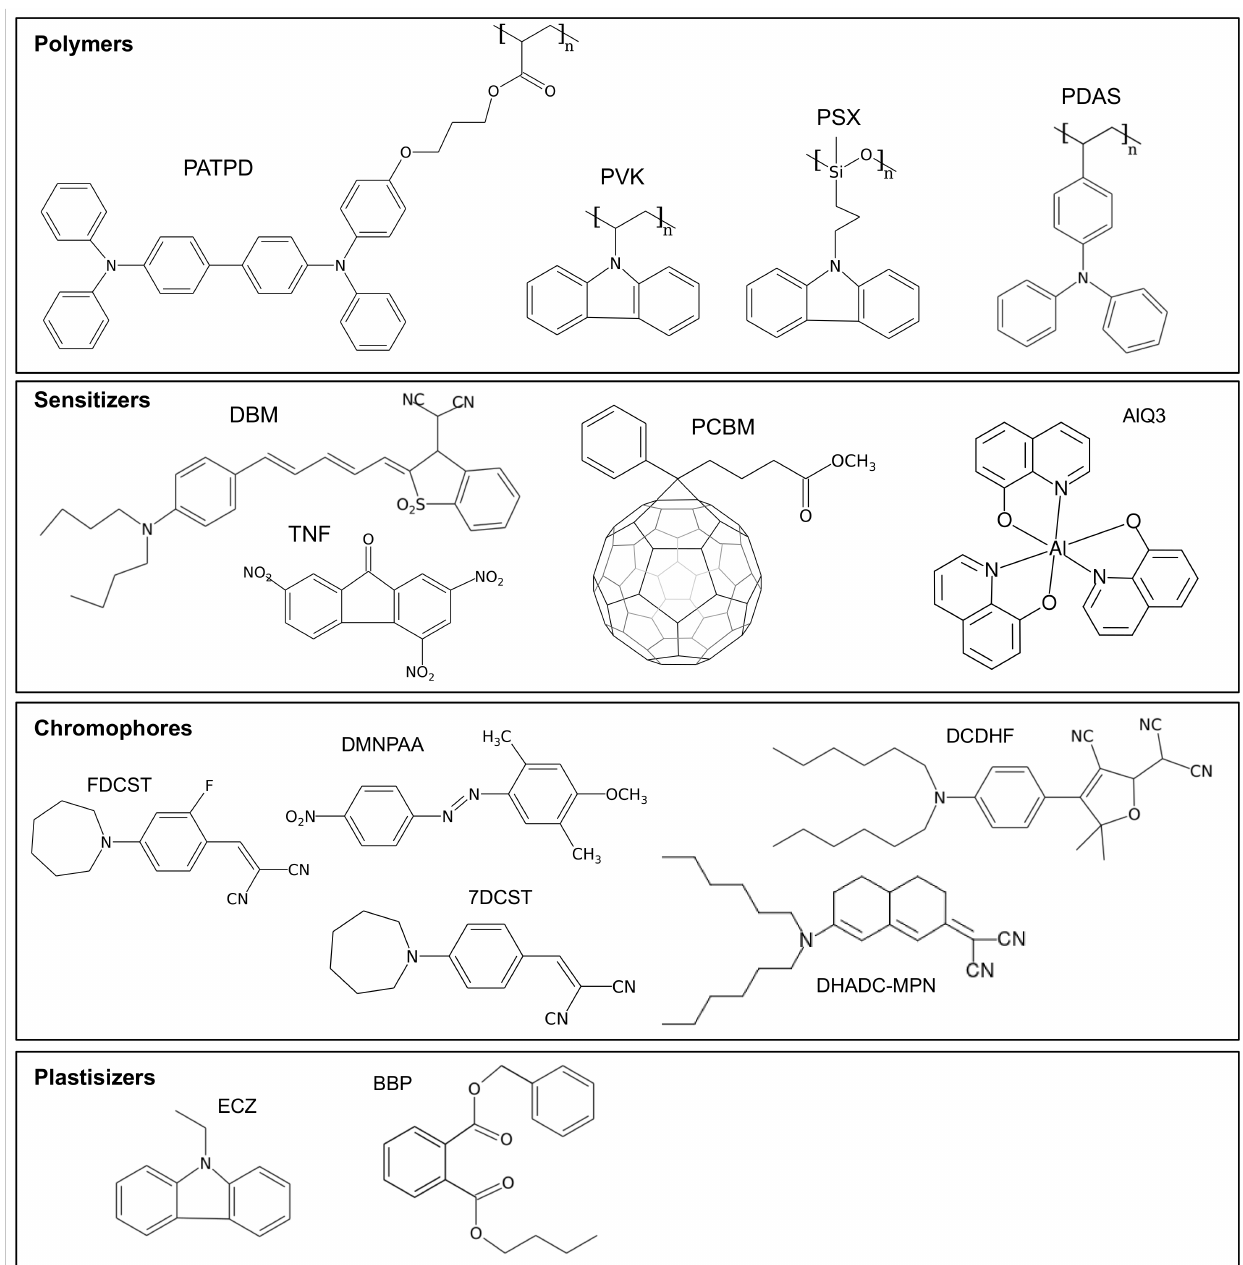
Figure 3. Structure of the most commonly used molecules found in photorefractive polymers. See text for chemical name and material